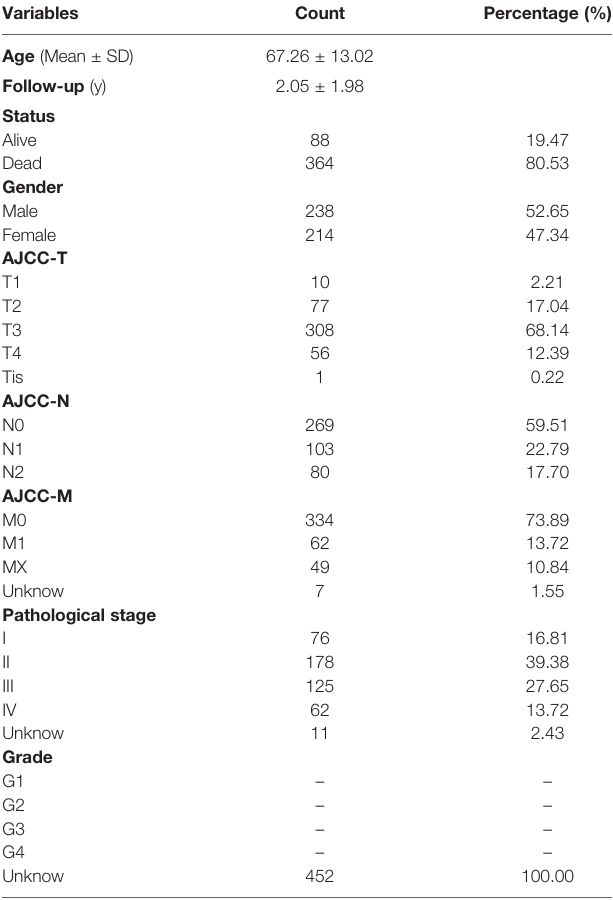
TABLE 1 | Baseline characteristics of 452 CRC patients included in this